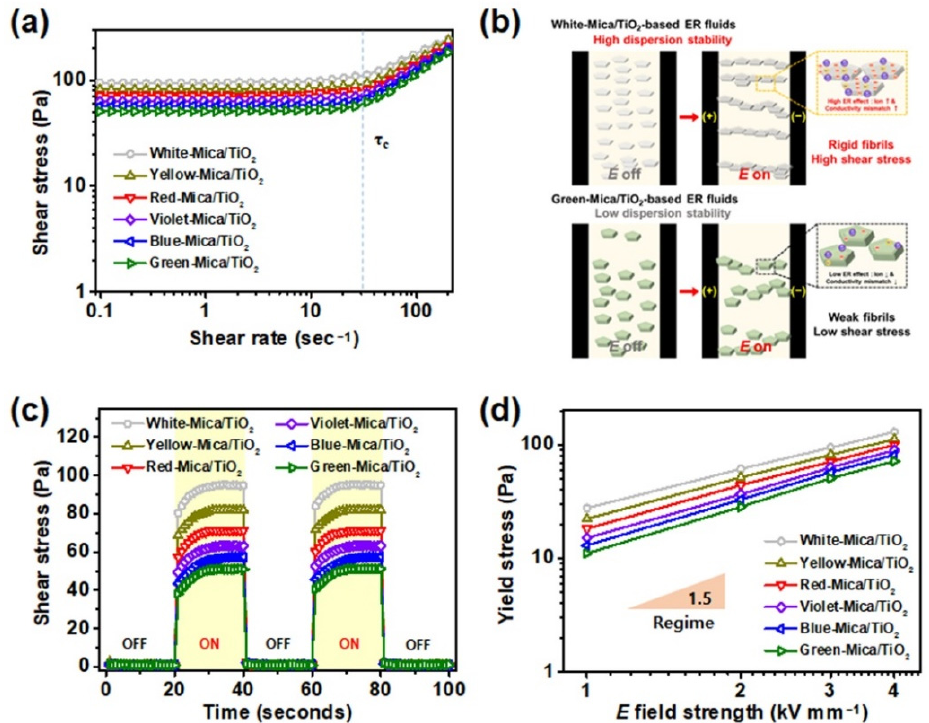
Figure 7. ( a ) Shear stresses of various color mica/TiO 2 -based ER fluids (3.0 wt%) as a function of shear rate with an applied E field strength of 3.0 kV mm − 1 . ( b ) Tentative mechanism for high and low ER efficiency difference between white and green mica/TiO 2 -based ER fluids according to the ion concentration, electrical conductivity, and dispersion stability. ( c ) E -field on–off test results with a fixed shear rate of 0.1 s − 1 and ( d ) yield stresses of various color mica/TiO 2 -based ER fluids (3.0 wt%) as a function of the E field strength with a fixed shear rate of 0.1 s − 1 .